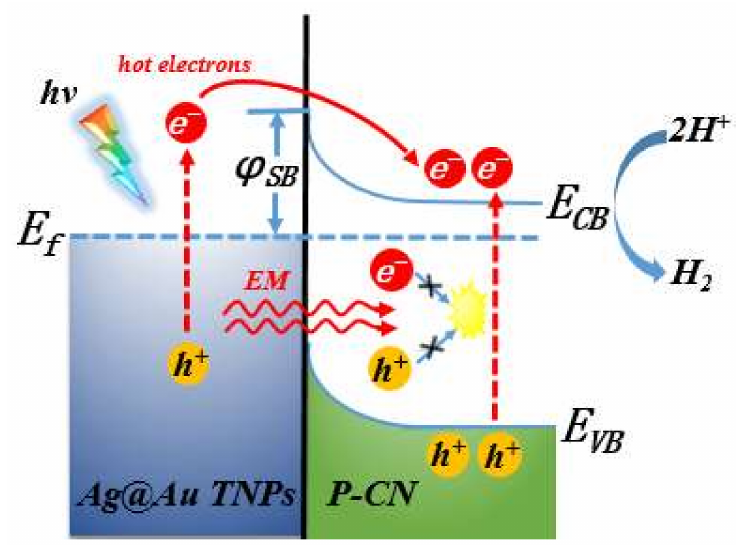
Figure 7. The proposed photocatalytic mechanism of Ag@Au TNPs/P–CN for H 2